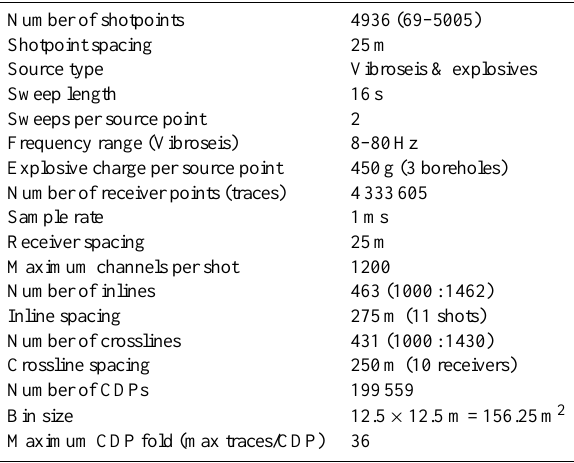
FIG. 1: a) Location of the study area within the Iberian Peninsula and detail of the main geological features and b) expected stratigraphy in the injection zone based on available seismic and borehole data. Table 1. Acquisition parameters of the Hontomín 3-D